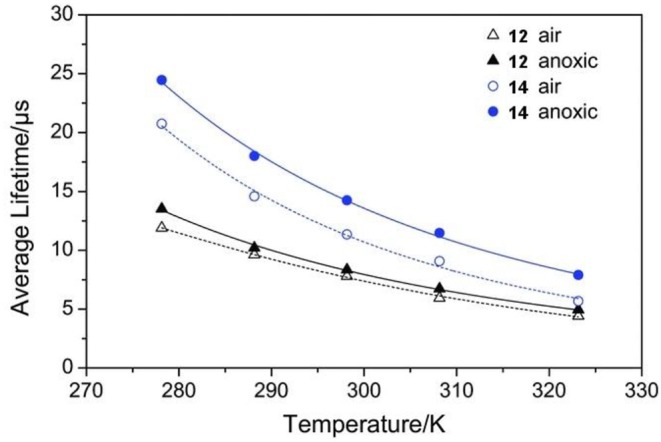
Temperature dependence of the average luminescence decay times of 12 and 14 ERL NPs. Adapted from reference (Steinegger et al., 2017) with permission from Wiley.